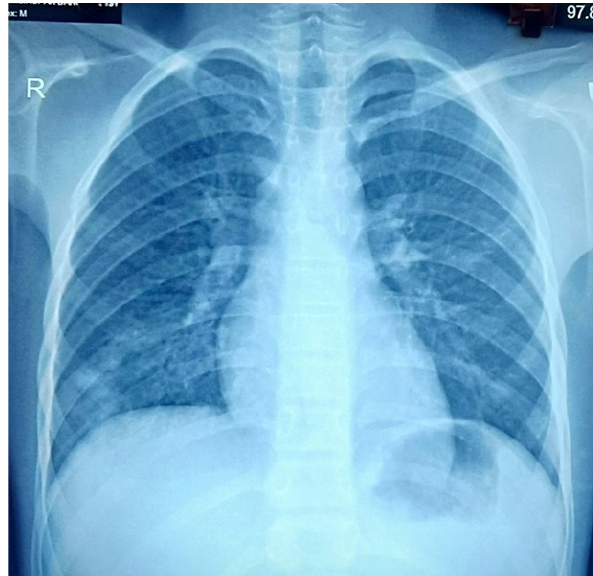
Figure 3: Chest x-ray (PA view) after bronchoscopy showing significant resolution of right lower zone consolidation and absence of foreign body